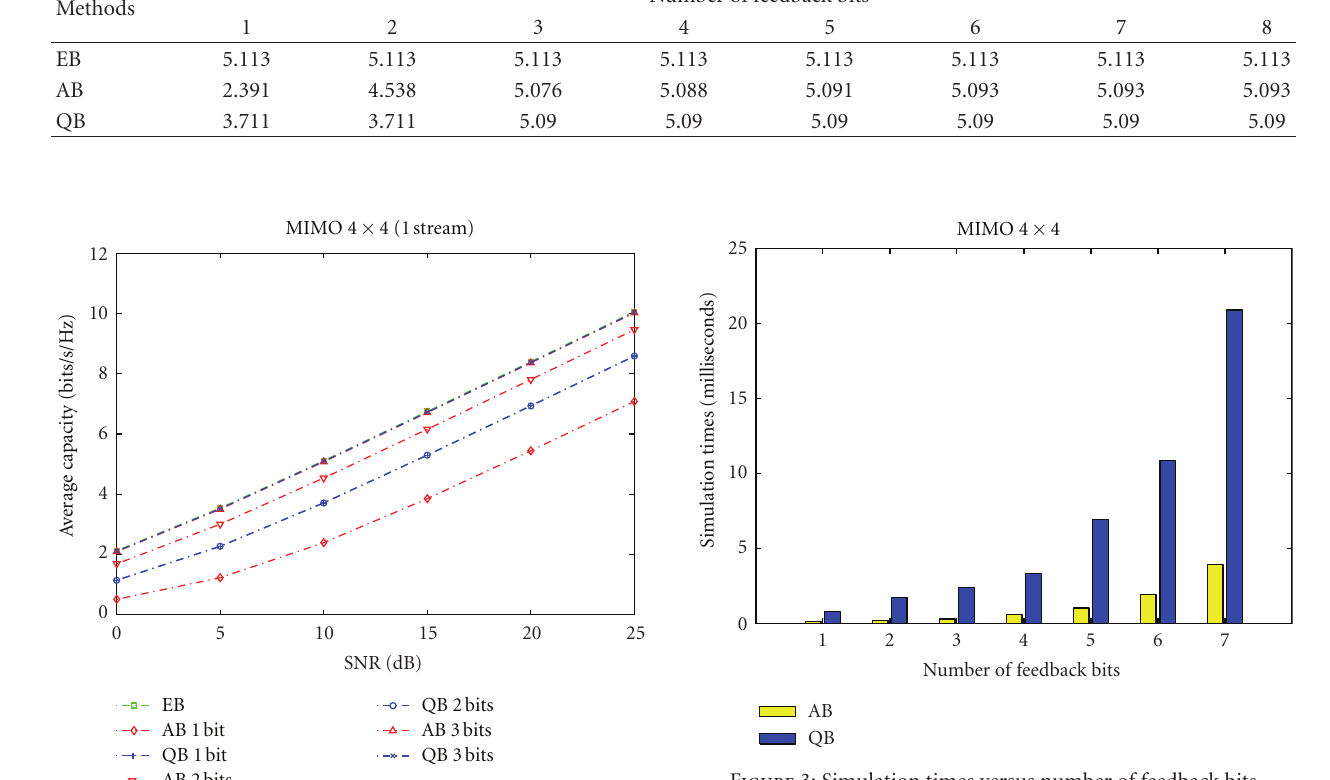
Figure 3: Simulation times versus number of feedback